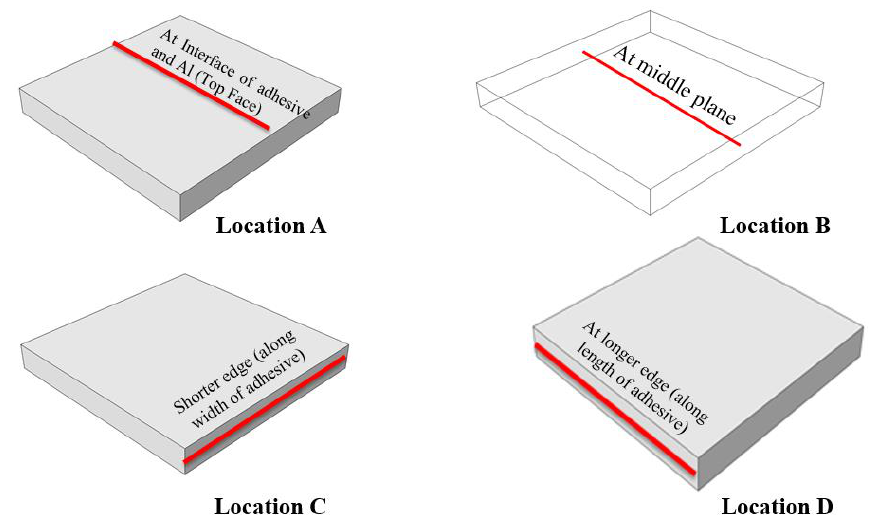
Figure 4. Selected specific locations to determine peel stress and shear stress.